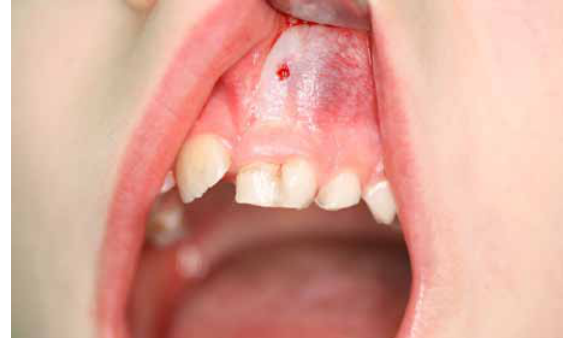
Figure 5. Case 6 (tab.1). Preoperative view.